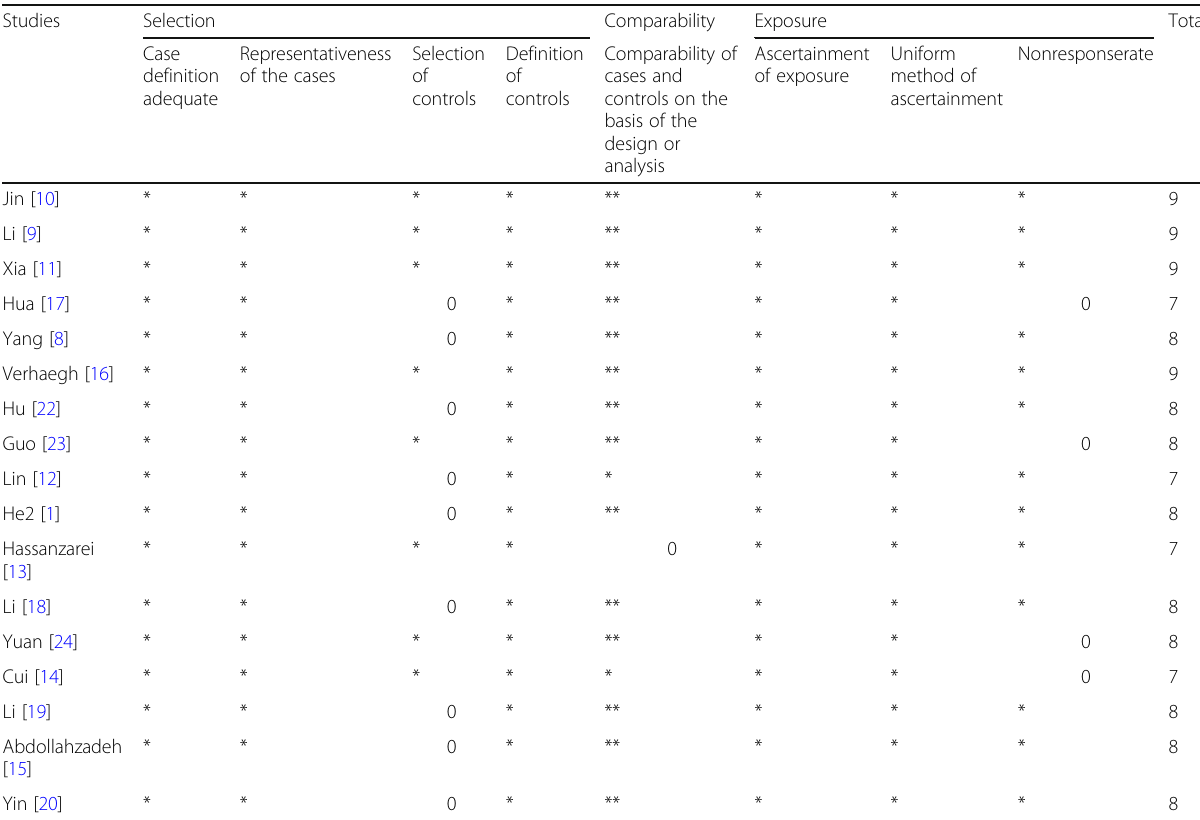
Table 3 Quality score